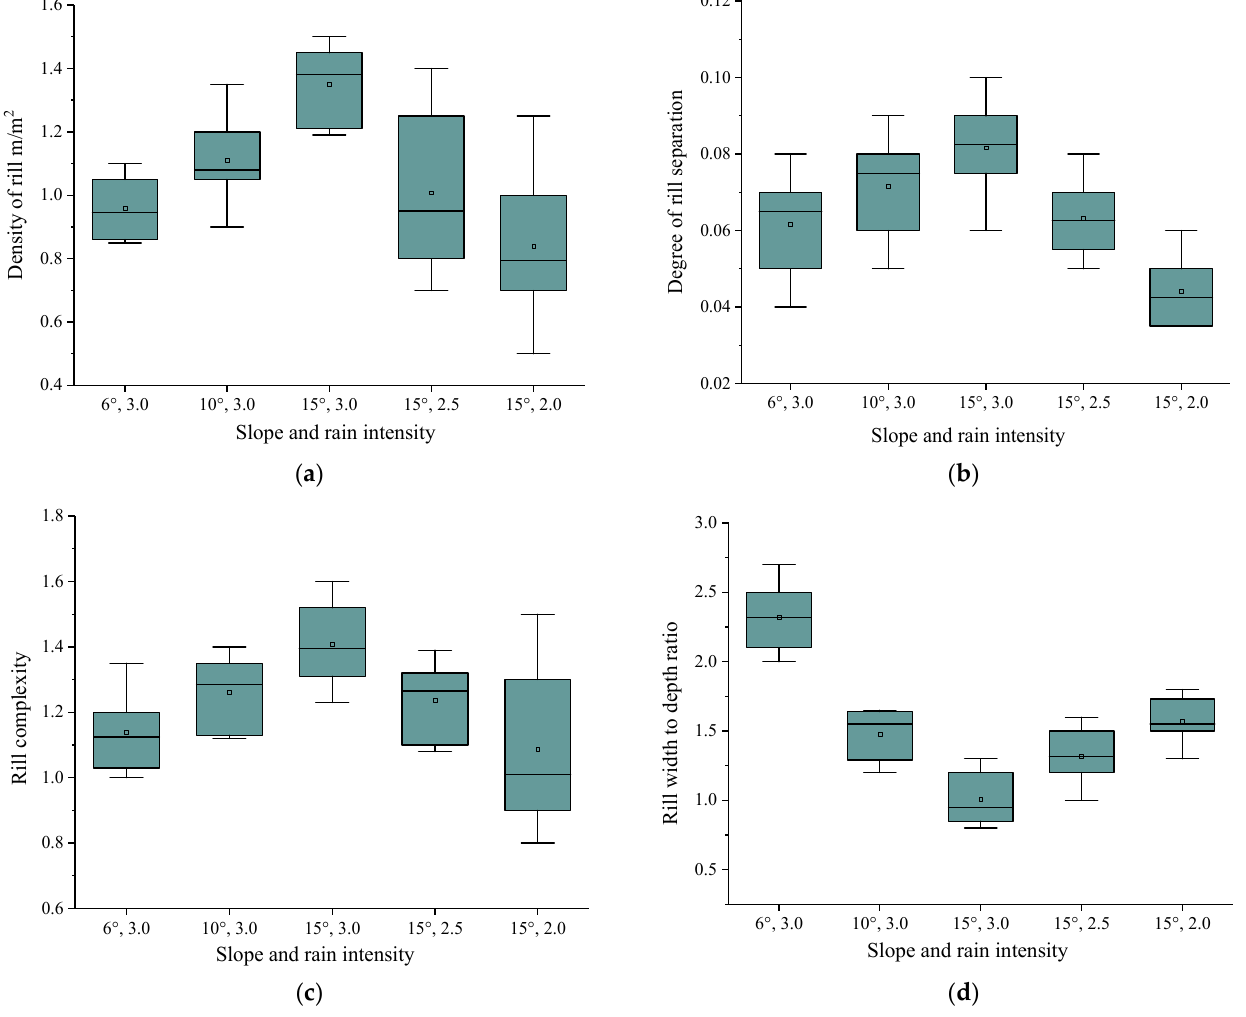
Figure 6. Variation of rill morphological indexes under different slopes and rainfall intensities. ( a ) density of rill; ( b ) degree of rill separation; ( c ) rill complexity and ( d ) rill width to depth ratio.